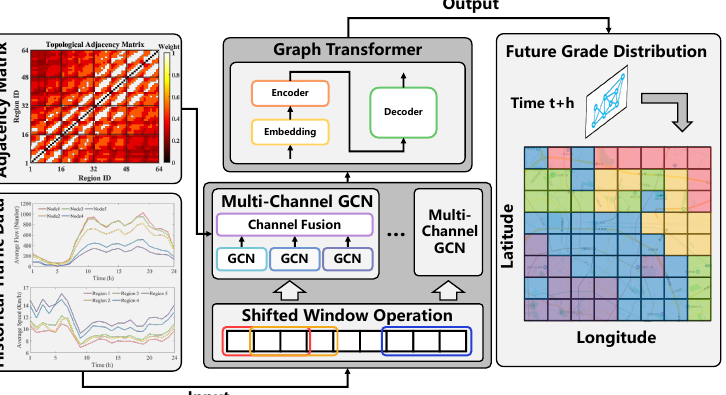
Figure 4. Overall architecture diagram of SSGformer. Historical traffic data is firstly divided into different segments by shifted window operation, and then multi-channel GCN operation is performed on different historical segments in parallel based on the topological adjacency matrix to obtain spatial correlation characteristics. Then, the Graph Transformer module is used to further complete the extraction of time-related features. Finally, the traffic grade of all regions is output in the whole graph corresponding to the time of practice t + h . Specifically, the Chinese characters in the regional grade map represent the names of roads and landmark